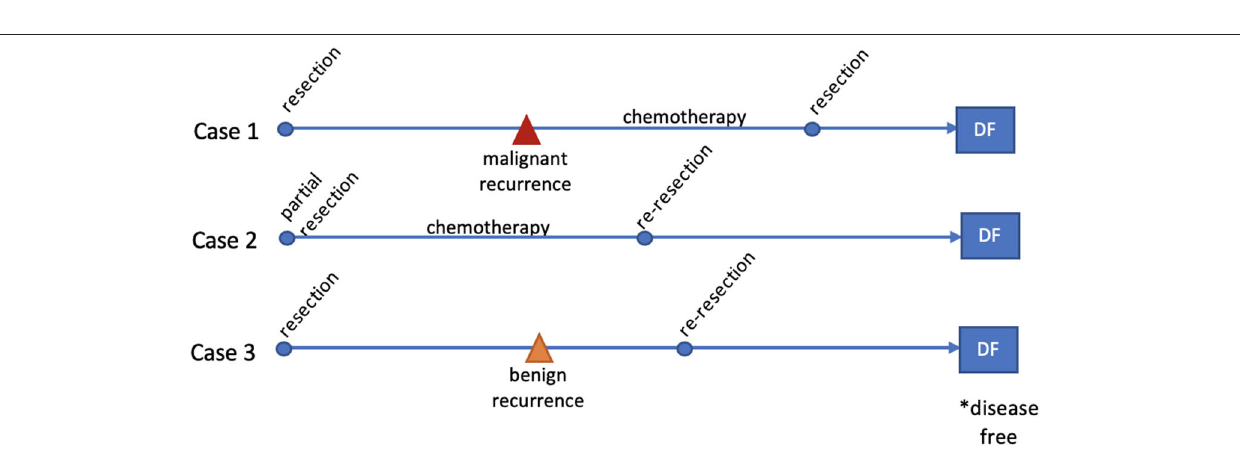
FIGURE 3 | MRI images from Case 3: (A) Coronal section at level of iliofemoral vessels shows large, laterally encapsulated retroperitoneal tumor; (B) Coronal section posterior to (A) shows deformation of abdominal aorta (solid arrows) by tumor, and infiltration of left renal hilum (LRH) causing hydronephrosis.